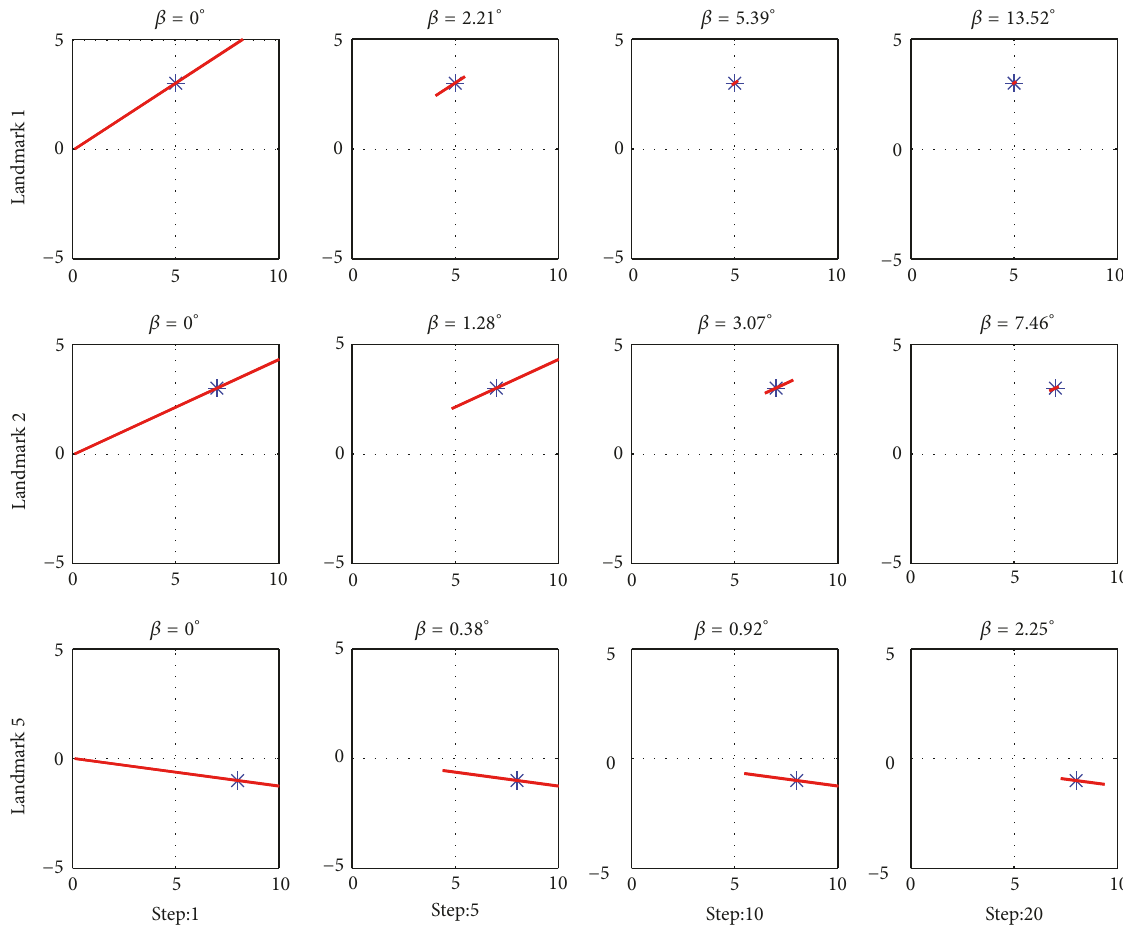
Figure 7: Interval uncertainty evolution.